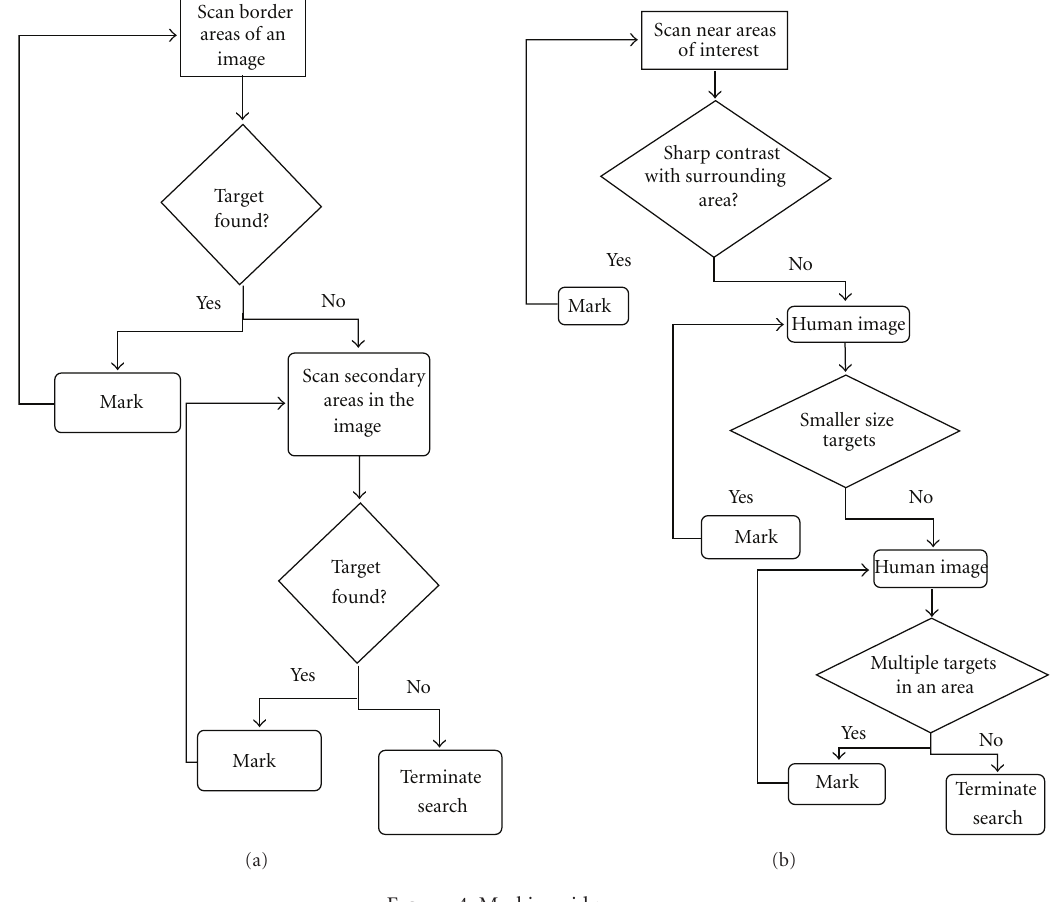
Figure 4: Marking aid